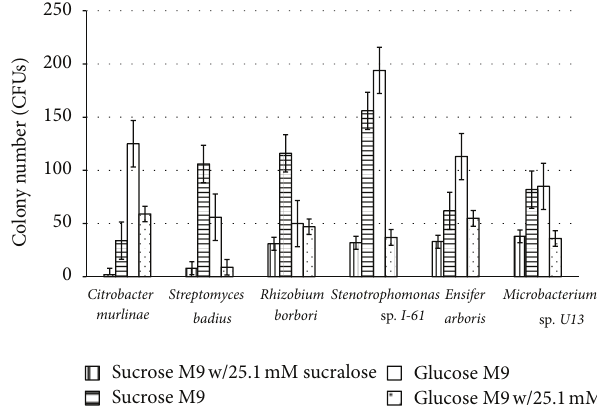
Figure 3: Cell death graph for comparison of inhibition on different carbon source media. Each isolate was cultured in equimolar (111mM) amounts of either sucrose or glucose as their carbon source, with half the samples also containing sucralose. Finally colony counts were performed.